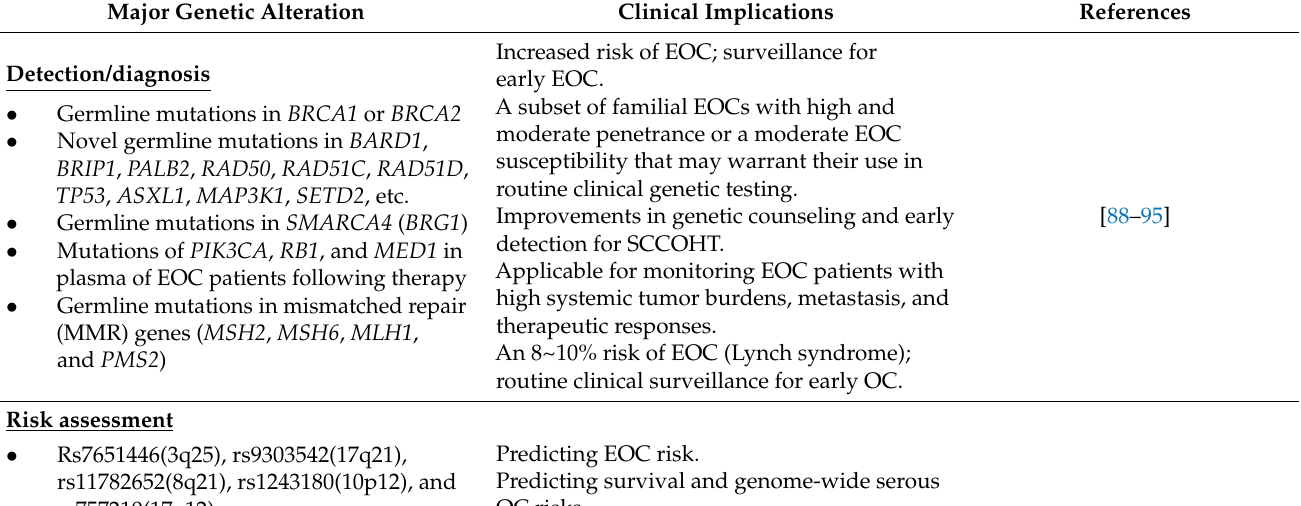
Table 2. Summary of selected genetic alterations and their clinical significance in ovarian carcinomas. Major Genetic Alteration Clinical